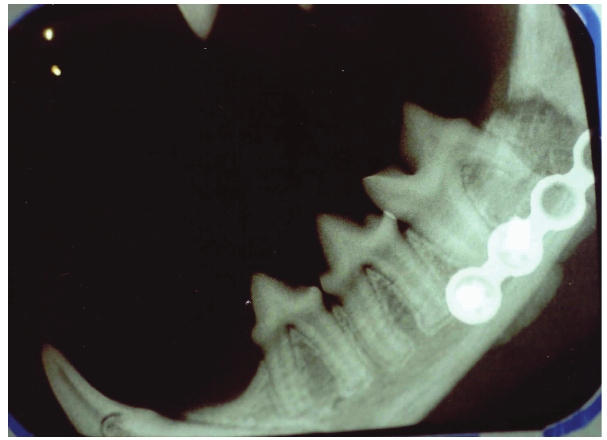
FIGURE 5 - Intraoral radiograph taken 1 week after surgery shows the segmental defect filled with autogenous bone graft. Cat 14 of Group 1.